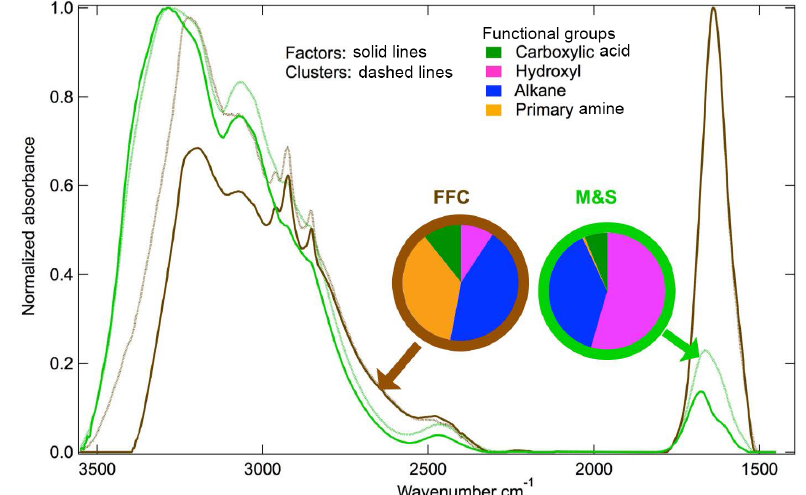
Figure 4. Normalized spectra from k -mean clustering centroids and PMF factors. Functional group fractions of PMF factors are shown in the pie